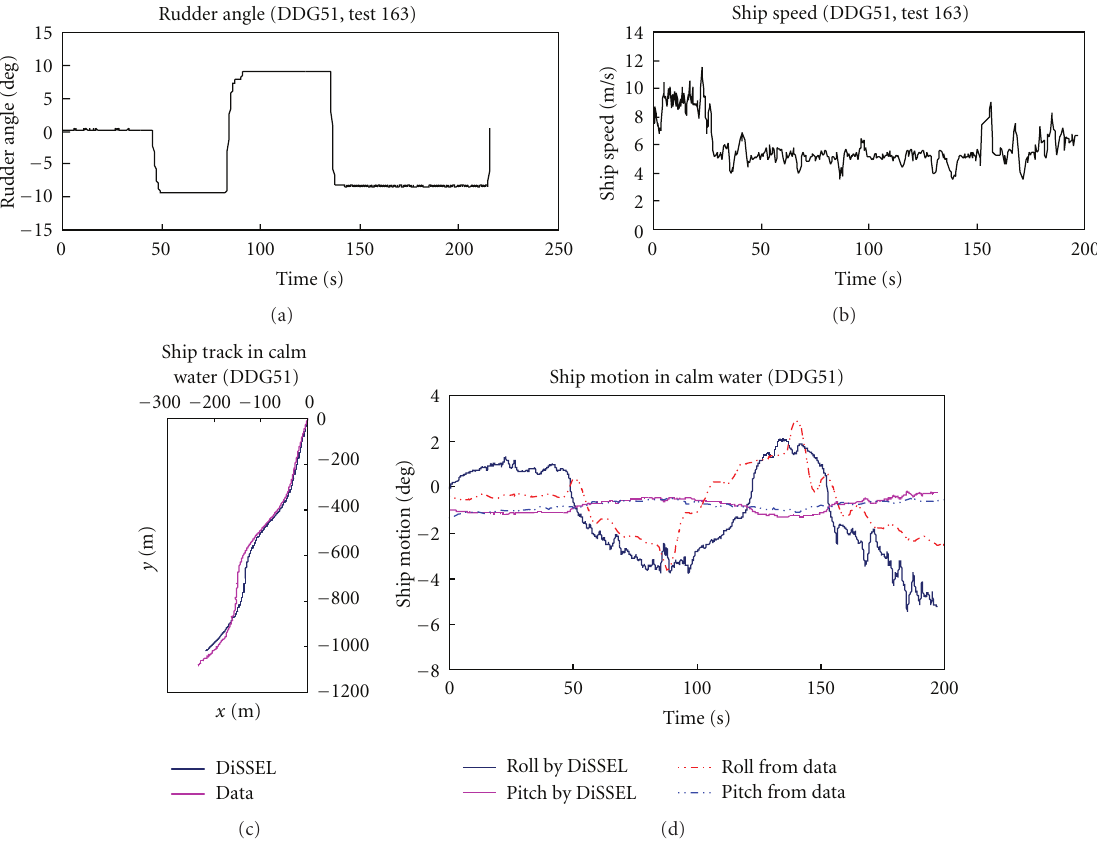
Figure 1: Input data for case 1 are shown in (a) and (b). (a) Rudder angle from data in test 163, (b) ship speed from data in test 163. Benchmark simulations for case 1 are shown in (c) and (d). (c) Comparison of ship tracks between simulation and experimental data in test 163, (d) Comparison of roll and pitch motions between simulations and data in